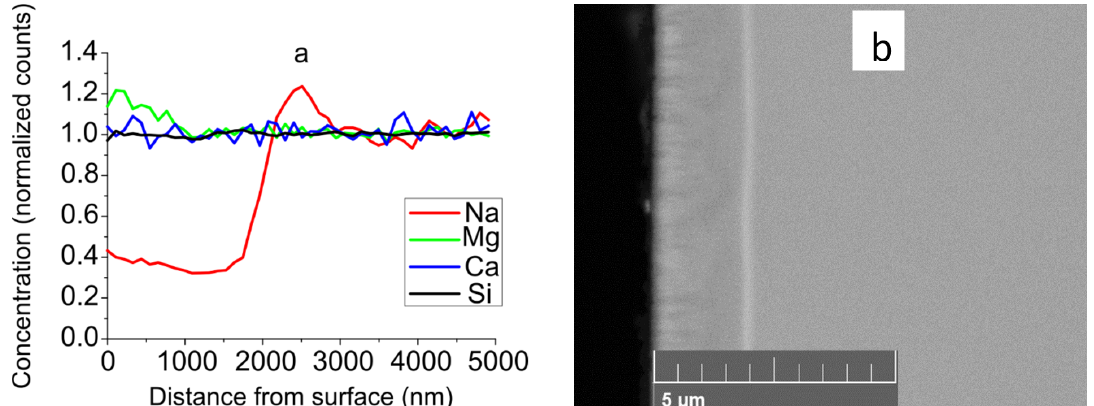
Figure 1. Sodium concentration profile ( a ) and localization of “frozen” electric charge ( b ) in thermally poled Menzel glass slide (white line on light gray background, glass surface corresponds to black–light grey interface). Table 1. Atomic composition of studied glasses.